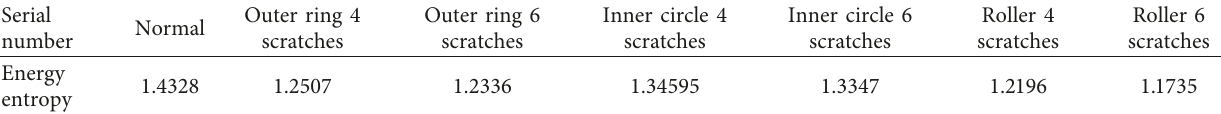
Table 1: Selecting 6 types of fault conditions and calculating their energy entropy.